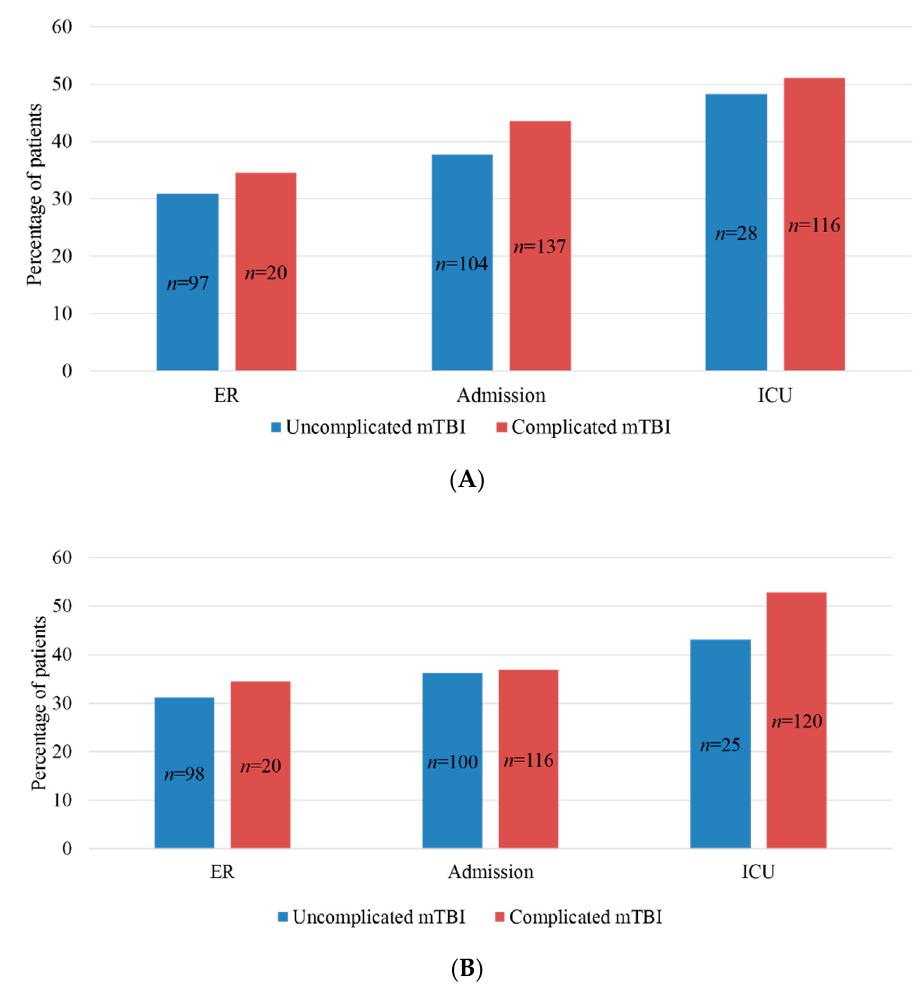
Figure 6. ( A ) Number and percentage of uncomplicated and complicated mTBI with PCS di ff erentiated Figure 6. (A) Number and percentage of uncomplicated and complicated mTBI with PCS by strata at 3 months. ( B ) Number and percentage of uncomplicated and complicated mTBI with PCS differentiated by strata at 3 months. (B) Number and percentage of uncomplicated and complicated di ff erentiated by strata at 6 months. PCS, post-concussion syndrome; mTBI, mild traumatic brain mTBI with PCS differentiated by strata at 6 months. PCS, post-concussion syndrome; mTBI, injury; ER, emergency room; ICU, intensive care mild traumatic brain injury; ER, emergency room; ICU, intensive care unit.